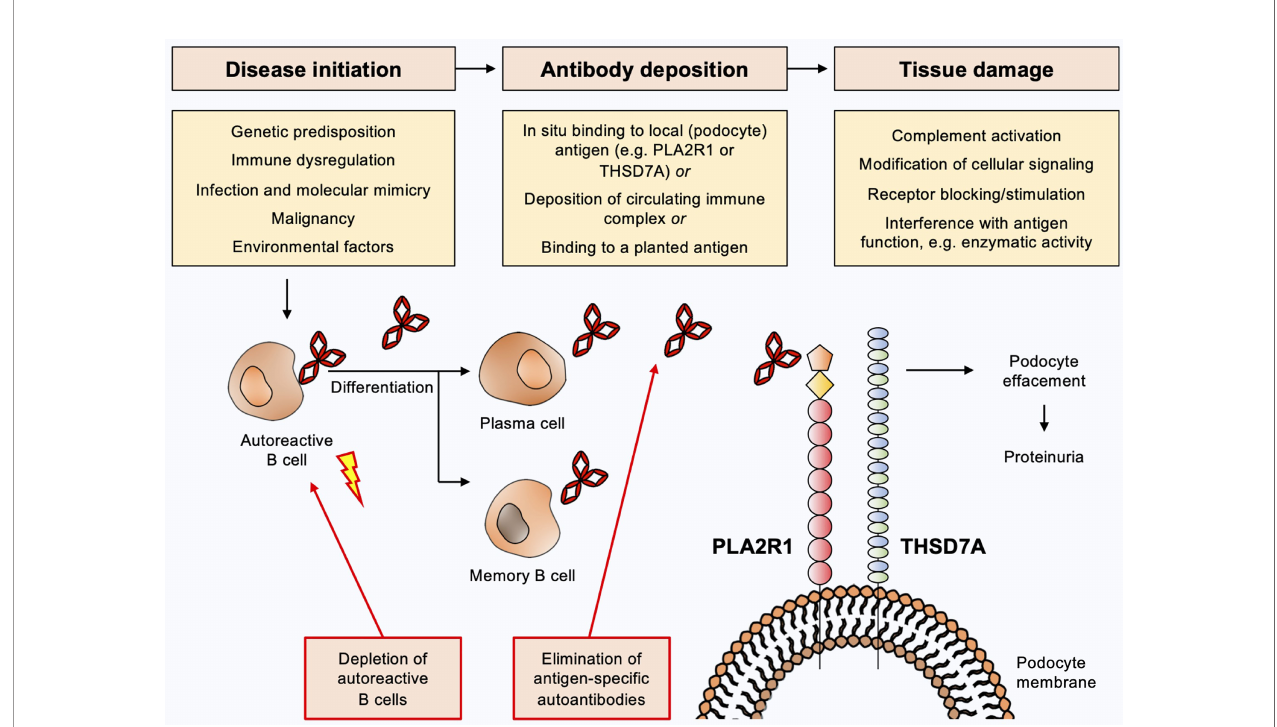
FIGURE 1 | Current view on the pathogenesis of membranous nephropathy and potential targets for antigen-speci fi c treatments. Predisposing factors such as underlying genetic dispositions and/or immune dysregulation in combination with an initiating trigger such as an infection, a malignancy or environmental factors may lead to loss of tolerance for the respective autoantigen with consecutive activation of B cells and production of autoantibodies. B cells differentiate to plasma and/or memory B cells, which in turn produce large amounts of autoantibodies. These autoantibodies reach the kidney via the circulation and bind to their target antigen (e.g. PLA2R1 or THSD7A), which induces damage to podocytes with subsequent urinary loss of plasma proteins. Complement-dependent and complement- independent injury mechanisms are likely to be involved. Depletion of autoantibody-producing B cells or elimination of pathogenic autoantibodies constitute potential antigen-speci fi c treatments for